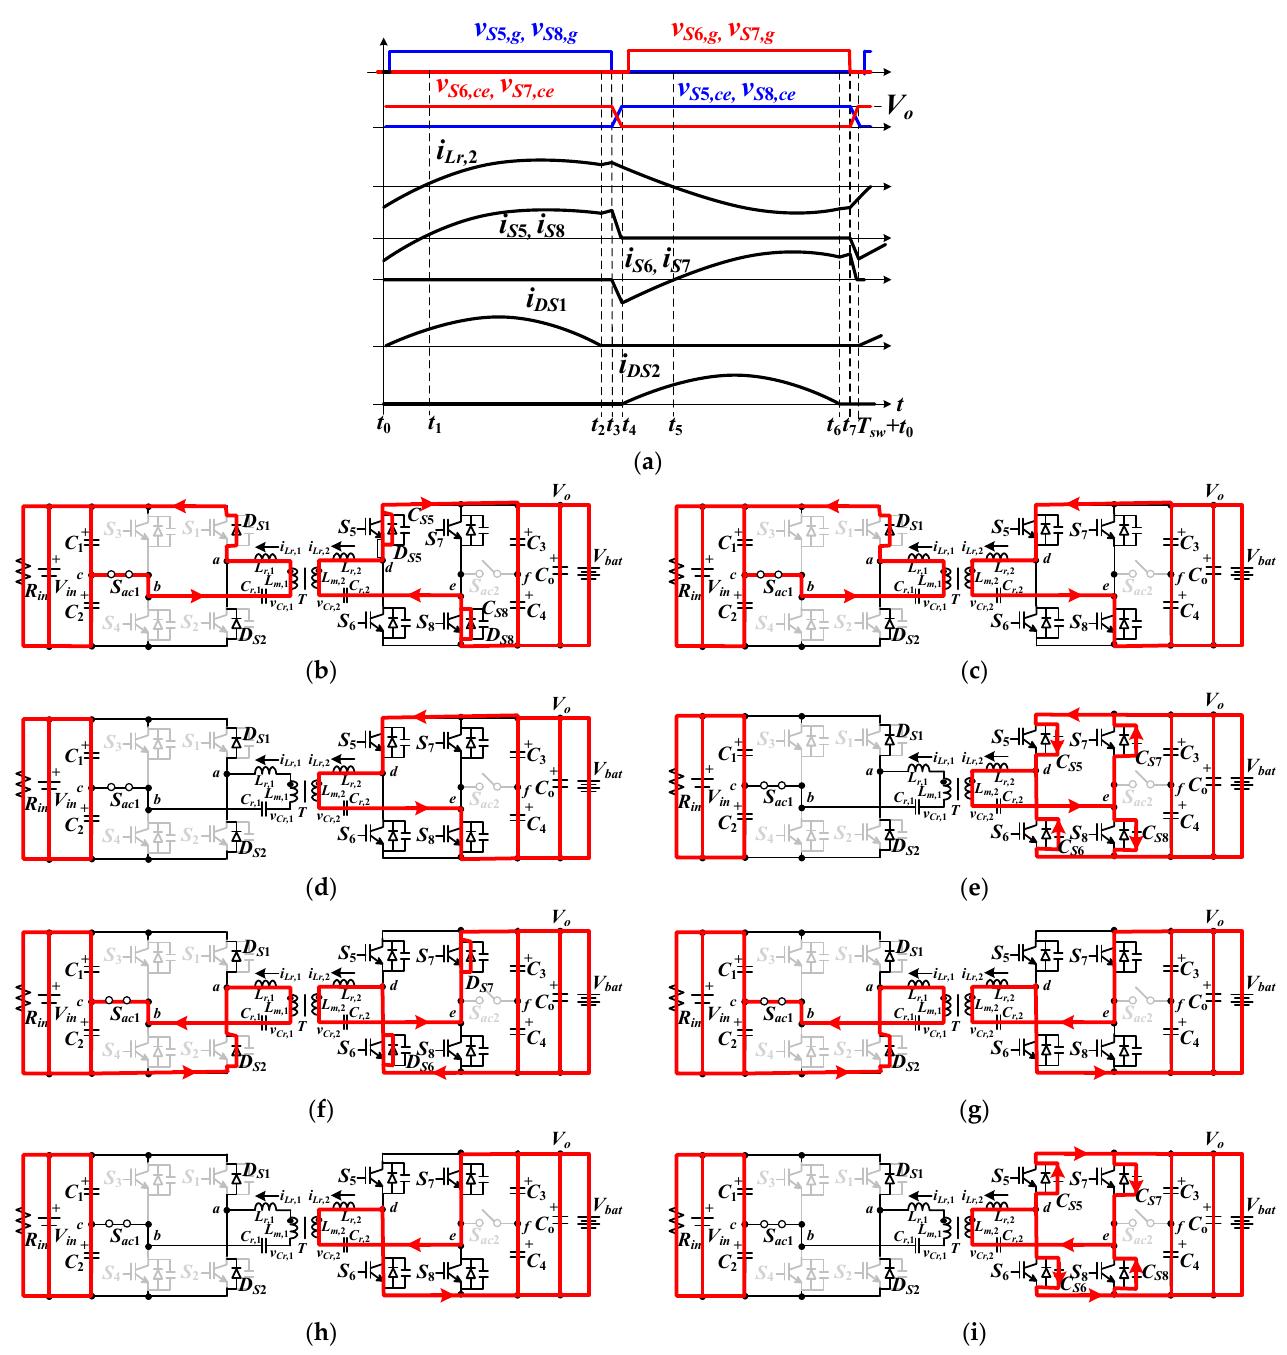
Figure 3. PWM signals and state circuits under backward power flow: ( a ) PWM signals; ( b ) State 1; ( c ) State 2; ( d ) State 3; ( e ) State 4; ( f ) State 5; ( g ) State 6; ( h ) State 7; ( i ) State 8.